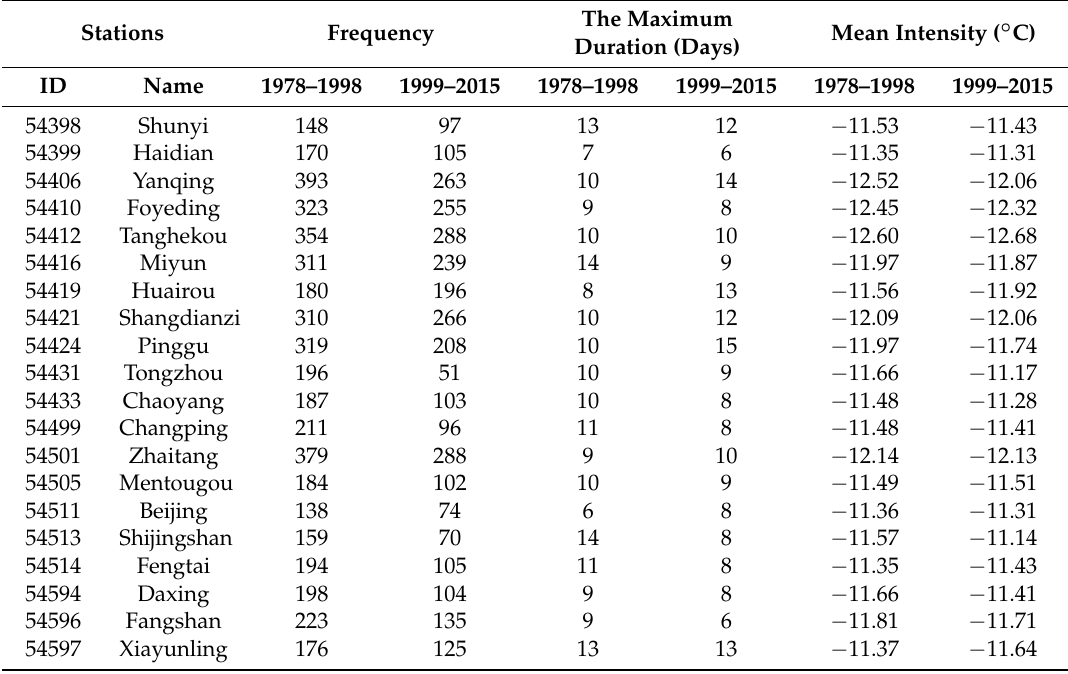
Table 3. Statistics of low temperature events for 20 meteorological stations in